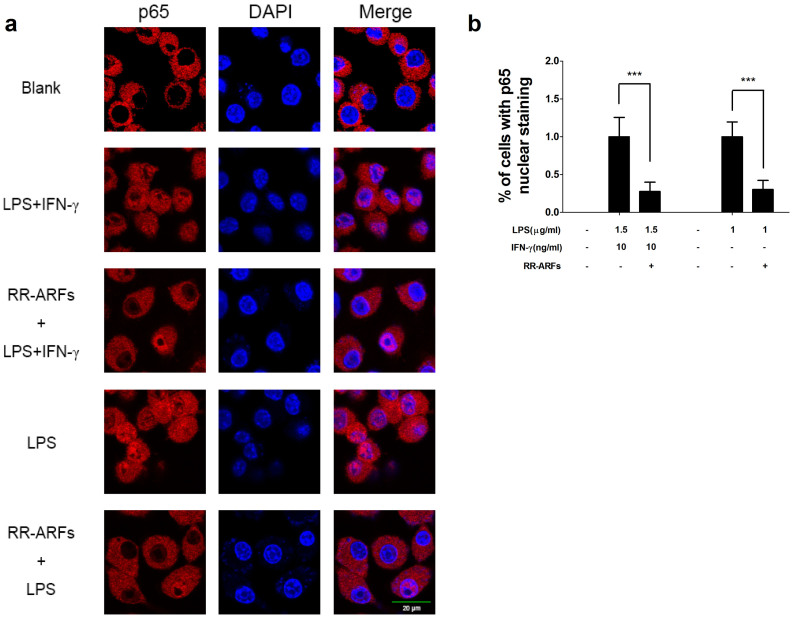
RR-ARFs inhibit LPS/IFN-γ-induced nuclear translocation of NF-κB (p65).RAW264.7 cells were pretreated with or without RR-ARFs (200 μg/ml) for 12 h and then exposed to LPS/IFN-γ or 1 μg/ml LPS only for 1 h. Then cells were fixed, permeabilized and immunofluorescent staining performed for p65. Nuclei were stained with DAPI (a). The relative percentage of p65 translocation compared to LPS/IFN-γ control was quantified based on three independent experiments, and *** P < 0.001 (b).